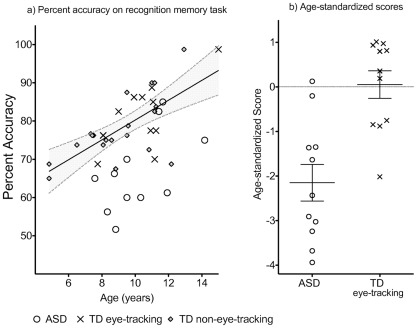
Scores on the recognition memory task.a) Percent accuracy and age of participants in the ASD, TD eye-tracking and TD non-eye-tracking groups. Regression line is based on all the TD participants’ scores (R2 = 0.45). b) Age-standardized scores of the ASD and TD eye-tracking groups. Bars show group means and standard error means.